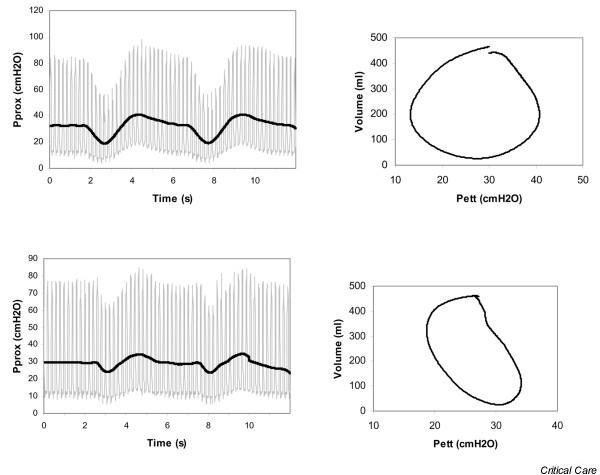
Pressure recordings of proximal airway pressure (Pprox; left panels) and modified Campbell diagrams (right panels) during simulated spontaneous breathing. Upper panels show recordings with continuous fresh gas flow; bottom panels show recordings with the demand-flow system. The left panels depict Pprox variation during two subsequent breaths. Thin lines represent unfiltered pressure signals and thick lines represent filtered Pprox. Note the reduced changes in both unfiltered and filtered signal with the demand-flow system (imposed pressure time product 17 cmH2O s versus 6.8 cmH2O s). Lines in the right panels represent mean lung pressure. Note the reduced surface area in the lower right panel. Imposed work of breathing is 1.2 J l-1 without the demand-flow system versus 0.5 J l-1 in the lower right panel with the demand-flow system. Pett, pressure at end of the tracheal tube.